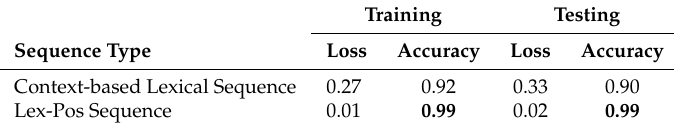
Table 14. Performance of Context-based and Lex-Pos Sequence on Author Model